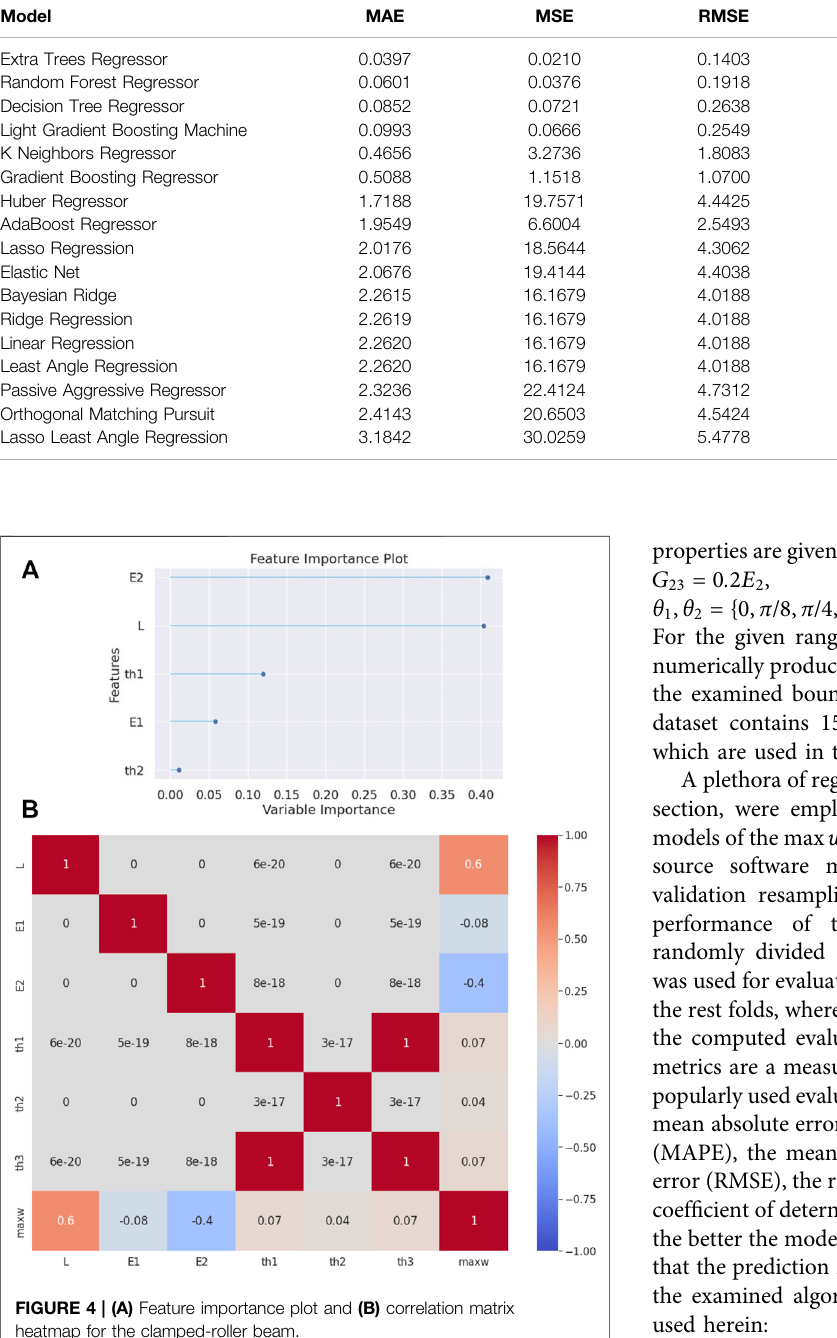
TABLE 4 | Evaluation metrics for the clamped-roller beam. Model Extra Trees Regressor